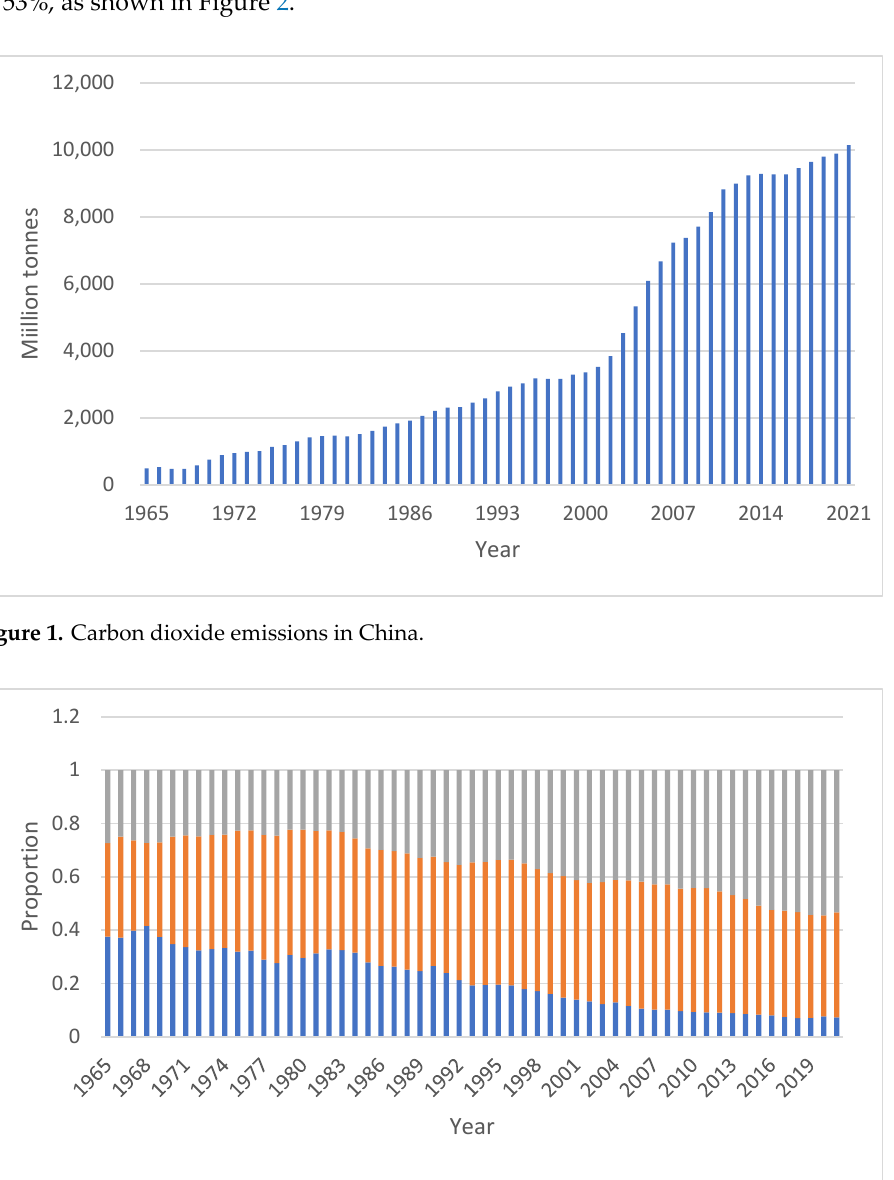
Figure 2. The proportion of primary, secondary, and tertiary industries.